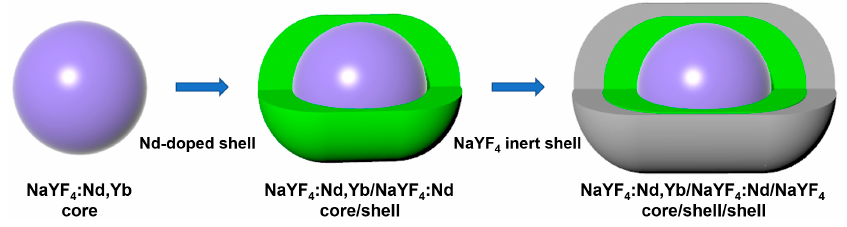
Scheme 1. Schematic illustration showing the formation of core/shell/shell-structured DSNPs.